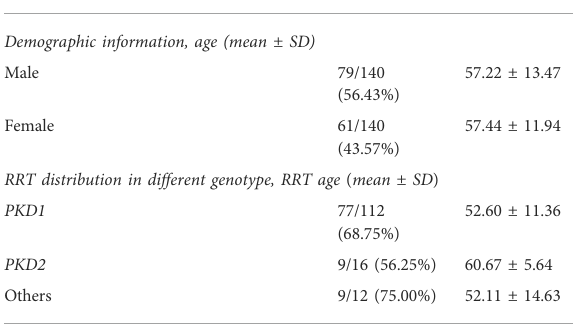
TABLE 1 Cohort information on ADPKD patients included in this study (n = 140).